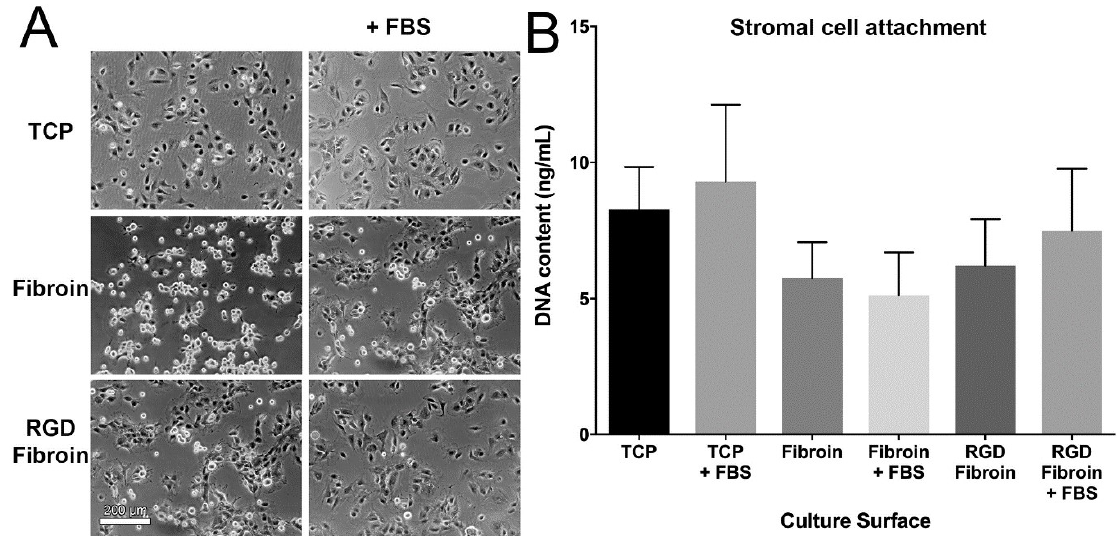
Figure 1. ( A ) Visual comparison of limbal stromal cell attachment to TCP, TCP coated with Fibroin (BMSF), or TCP coated with RGD-Fibroin. Cells were seeded at a density of 15,000 cells/cm² in 24-well culture plates and incubated for 90 min in the absence or presence of FBS in the culture medium. Phase contrast images display the typical appearance of cells after 90 min incubation followed by rinsing in phosphate-buffered saline. ( B ) Quantification of stromal cell attachment via measurement of dsDNA content using the PicoGreen assay. Bars represent the mean ± SEM for cultures derived from 5 unique donors. No significant difference between culture surfaces/conditions was detected (Friedman test with Dunn’s multiple comparisons test; n = 5).